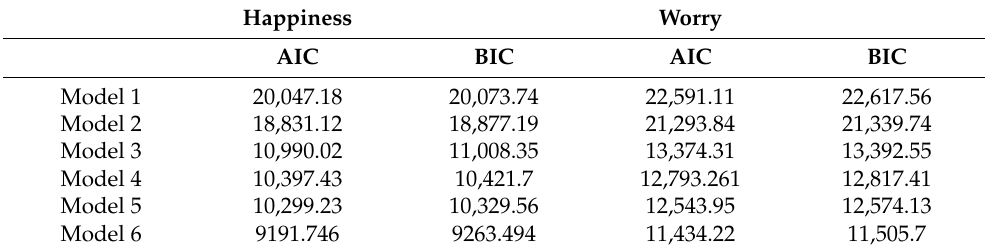
Table 1. AIC–BIC weights for the compared models.